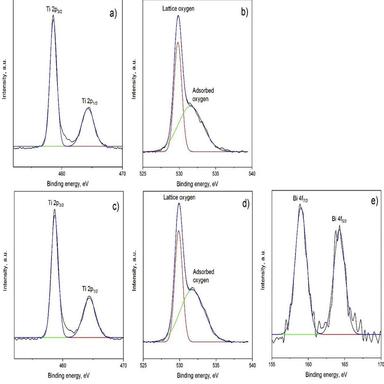
High resolution XPS spectra of PC500-based samples: a) Ti 2p spectrum of sample PC500; b) O 1 s spectrum of sample PC500; c) Ti 2p spectrum of sample PC500Bi30; d) O 1 s spectrum of sample PC500Bi30; e) Bi 4f spectrum of sample PC500Bi30.